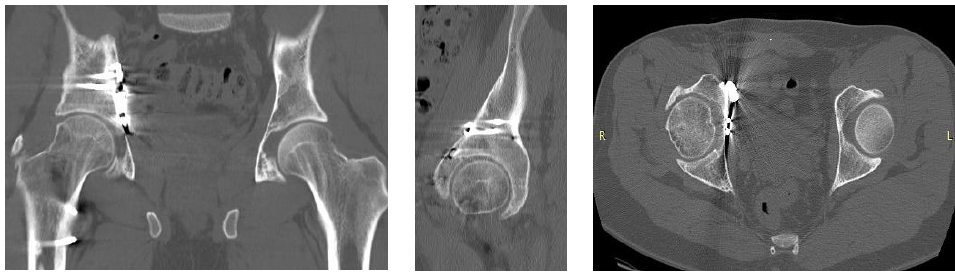
Figure 3. A 3D printed pelvis model of a patient with a preoperatively contoured anterior column plate, placed after fracture reduction, with no fixation of the iliac ring ( left ); a 3D printed model of a hemipelvis from another clinical case, generated via mirroring of the uninjured contralateral side, and visualized with a posterior column plate with temporary fixation ( right ).